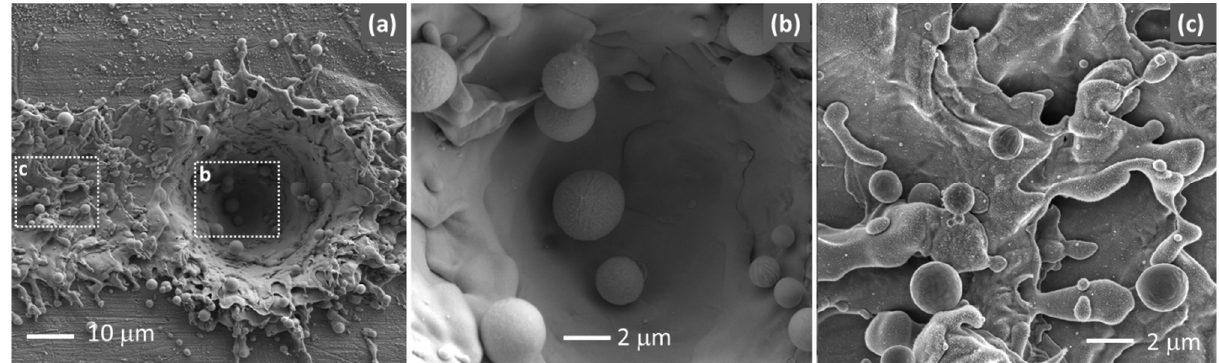
Figure 4. ( a ) SEM image of the copper surface laser-processed with bit-map method (300 dpi) around a “pixel”. Images ( b , c ) are selected areas from ( a ) using a higher magnification. Images ( a , b ) correspond to secondary electrons, and ( c ) corresponds to Inlens detector.